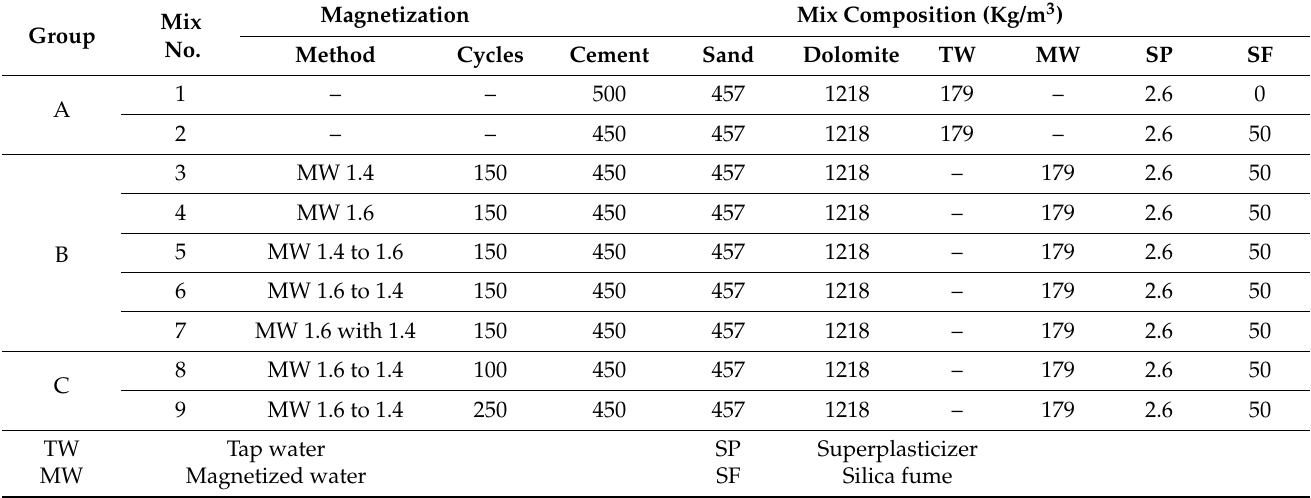
Table 3. Mix proportions for each